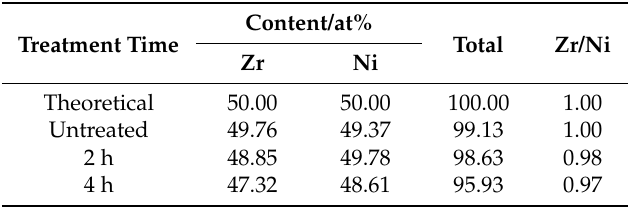
Table 2. Chemical composition of the ZrNi alloy powers with and without the boiling alkaline treatment for 2 h and 4